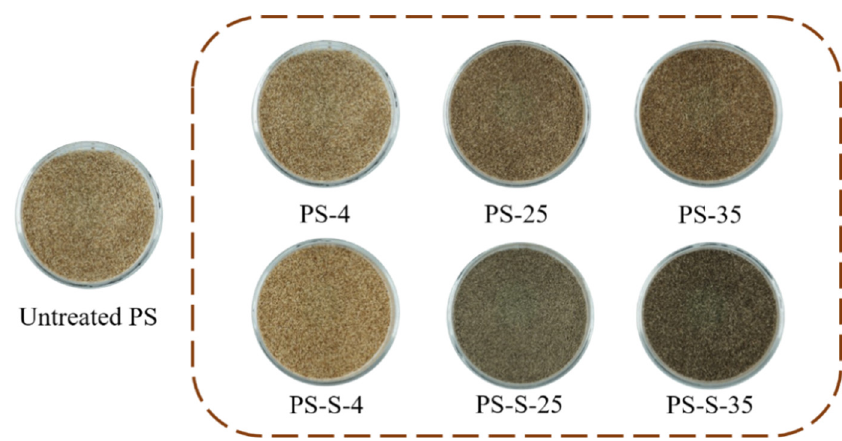
Figure 3. Color change of PS, PS-4, PS-25, PS-35, PS-S-4, PS-S-25, and PS-S-35 particles.